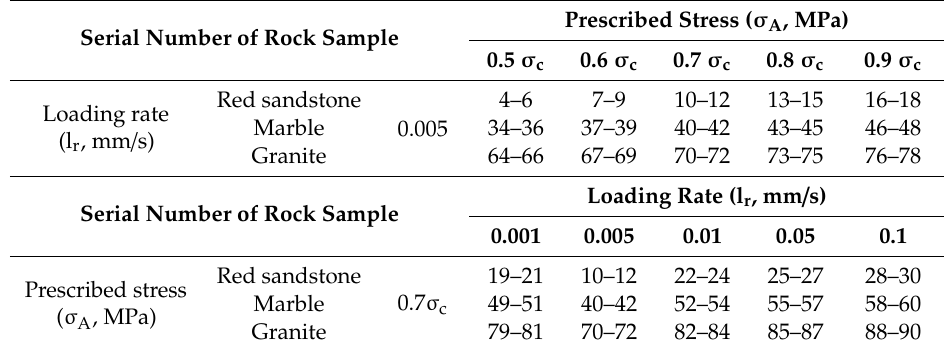
Figure 1. The microstructures and compositions of the three types of rock. Qtz—quartz, Pl—plagioclase, Kfs—potash feldspar, Cal—calcite, Anh—anhydrite, Bt—biotite. Table 1. Uniaxial cyclic loading–unloading compression of rock samples.